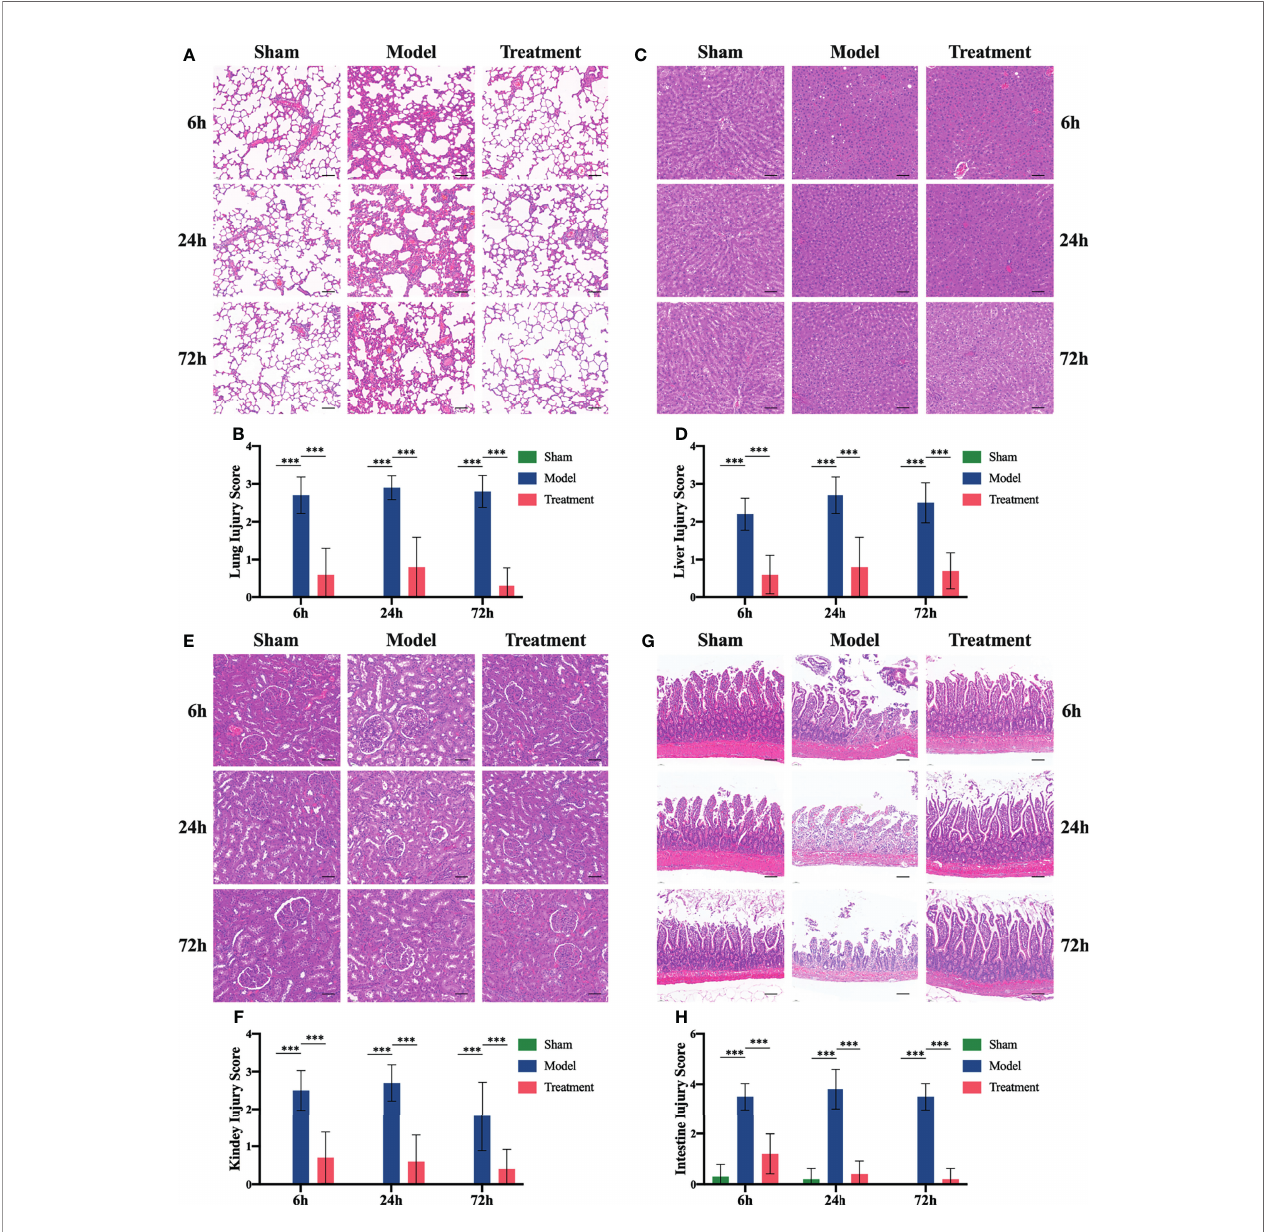
FIGURE 2 | HE staining and tissue damage scores of lung, liver, kidney and ileum of rats in each group. (A) HE staining of lungs at 6h, 24h and 72h in each group of rats; (B) lung tissue damage scores in each group of rats; (C) liver HE staining at 6h, 24h and 72h in each group of rats; (D) liver tissue damage scores in each group of rats; (E) kidney HE staining at 6h, 24h and 72h in each group of rats; (F) kidney tissue damage scores in each group of rats; (G) ileum HE staining at 6h, 24h and 72h in each group of rats; (H) ileal tissue damage scores of rats in each group. n=5, scale bar=100 m m,